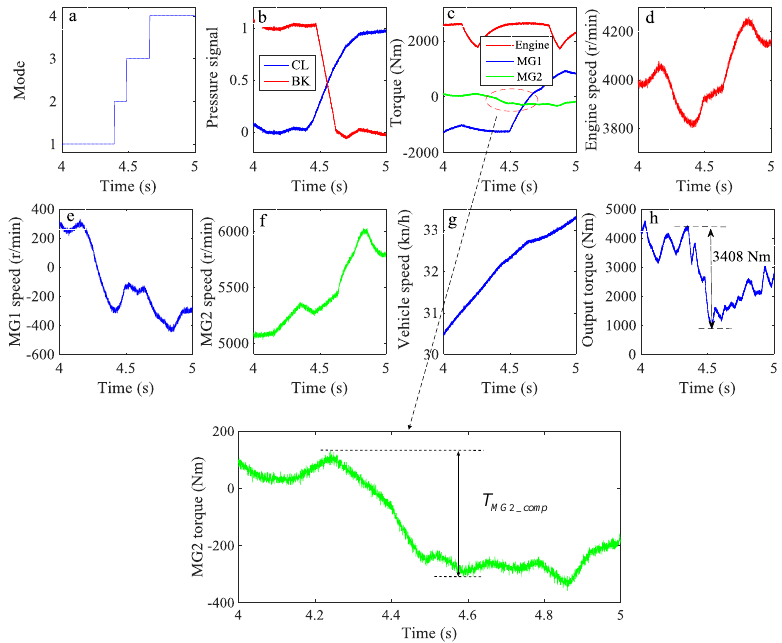
Figure 19. Experimental results of the hybrid HDV with control: ( a ) Mode; ( b ) Pressure signal; ( c ) Torques of Engine and MGs; ( d ) Engine speed; ( e ) MG1 speed; ( f ) MG2 speed; ( g ) Vehicle speed; and ( h ) Output torque.